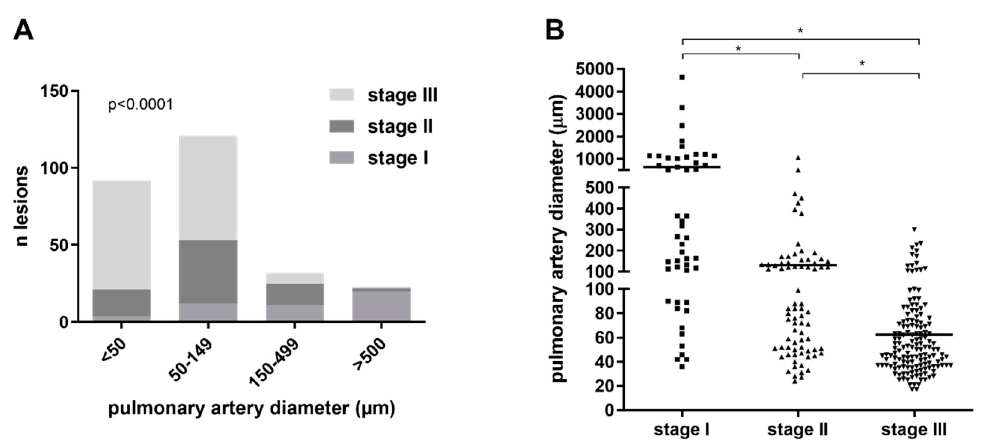
Figure 8. Quantification of angiophagy in right lower lobes of the large animal model of CTEPH. ( A ) Number ( n ) of each stage of angiophagic lesions among four different diameters of pulmonary arteries (axial cut); proportions of stages among diameter ranges were compared using Chi 2 tests. ( B ) Distribution of pulmonary artery diameter for each stage of pulmonary angiophagy (axial cut); the bar represents the median value; pulmonary artery diameters corresponded to the inner diameters measured between the inner borders of the media and were compared using Mann–Whitney tests; * p < 0.05.